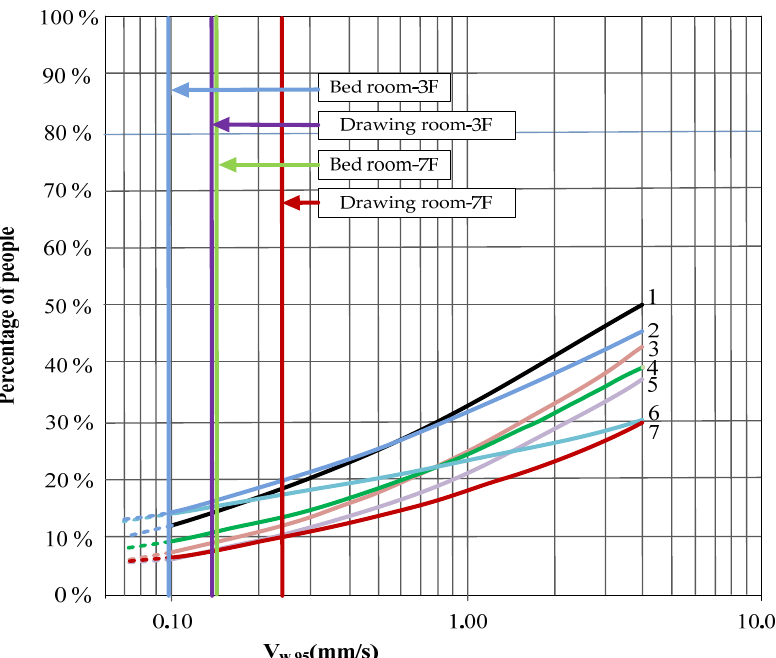
Figure 13. Percentage of people who were disturbed during rest or during daily activities by the vibrations in dwellings. The results are plotted against the calculated statistical maximum value for the weighted velocity, ν w ,95 , expressed in mm/s [17].